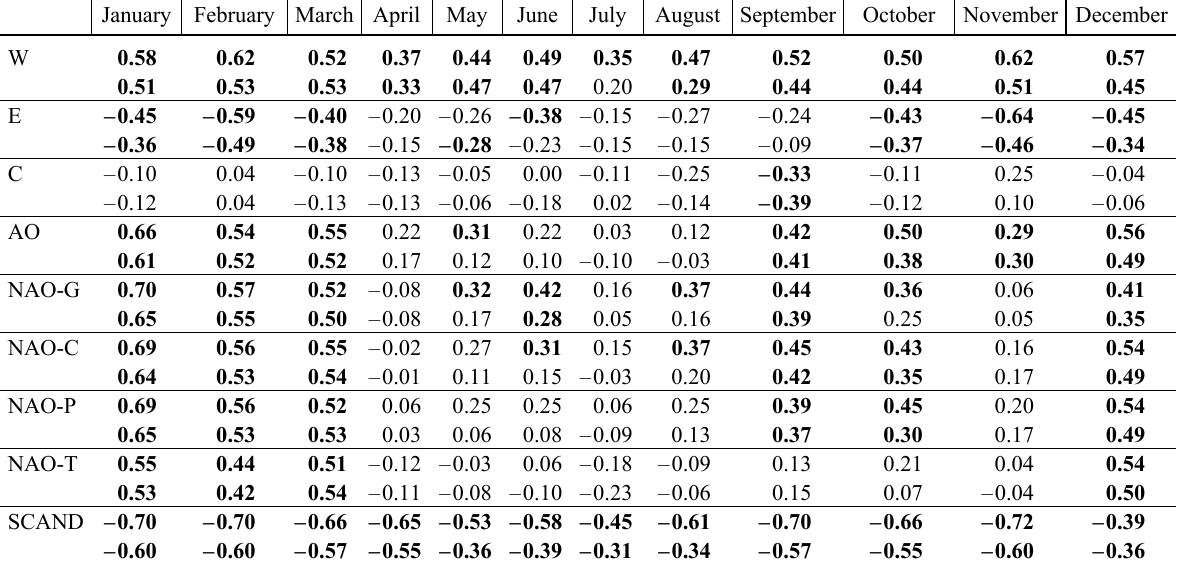
Table 5. Correlation coefficients between the monthly variables of atmospheric circulation (frequencies of circulation macroforms W, E and C according to the Vangengeim(cid:150)Girs classification, Arctic oscillation (AO) index, North Atlantic oscillation (NAO) indices and Scandinavian (SCAND) teleconnection pattern) and monthly mean sea levels (upper values in the boxes), and monthly maximum sea levels (lower values) in 1950(cid:150)2011. Statistically significant correlations on the p < 0.05 level are typed in